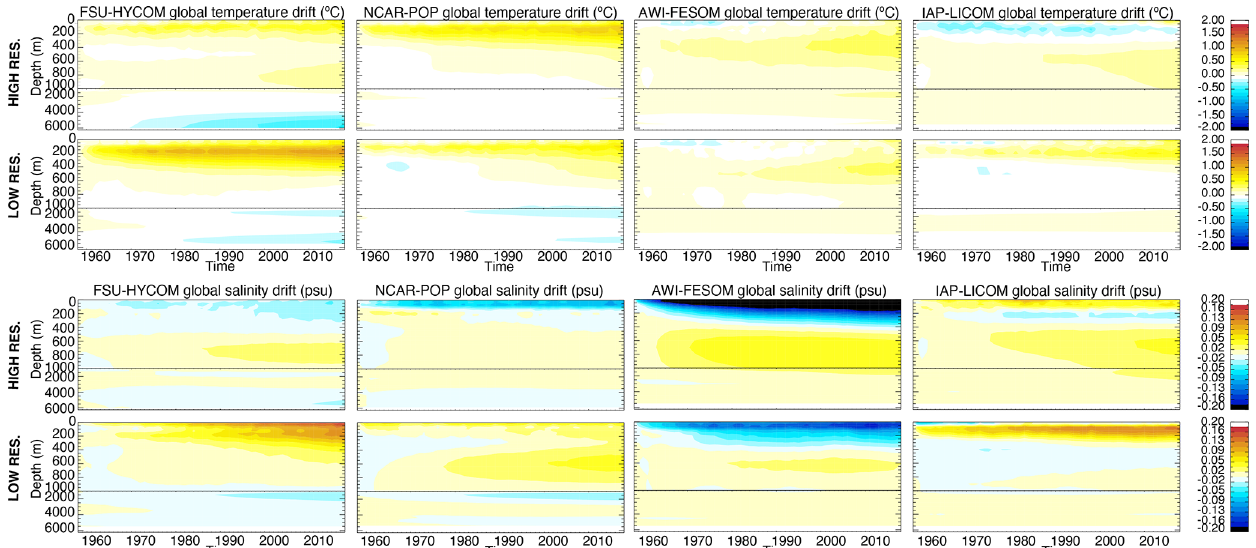
Figure 6. Time evolution of global temperature ( ◦ C) and salinity (psu) change (relative to initial conditions) as a function of depth for all experiments.